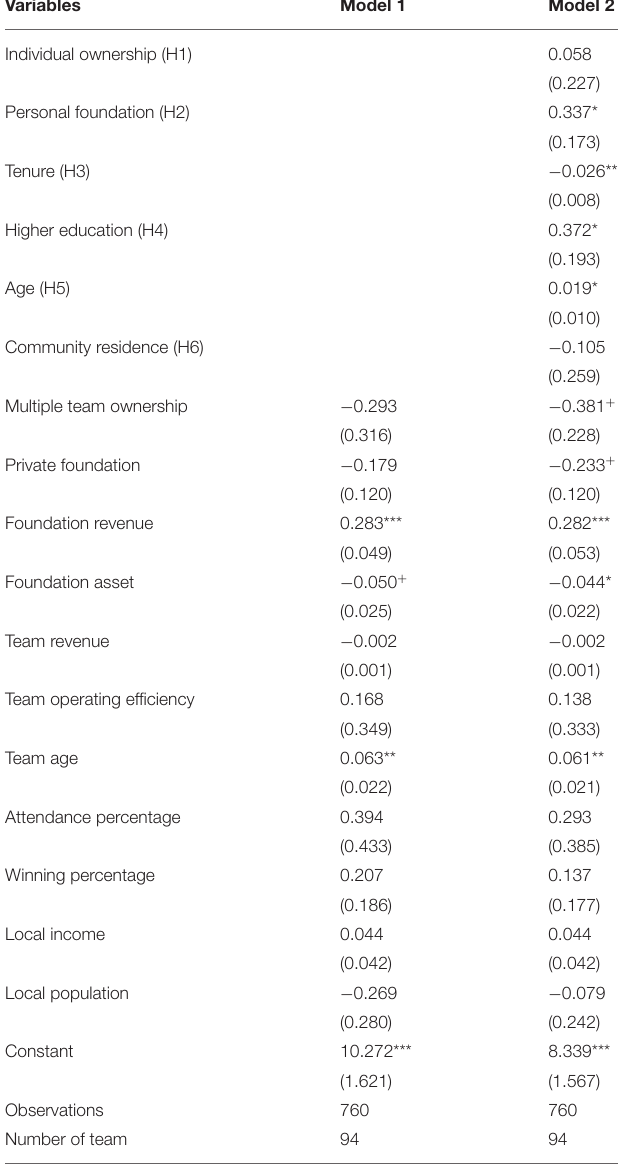
TABLE 2 | Effect of owner characteristics on team philanthropic